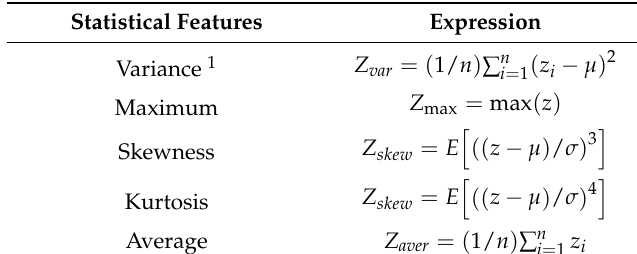
Table 7. The list of manually extracted features.